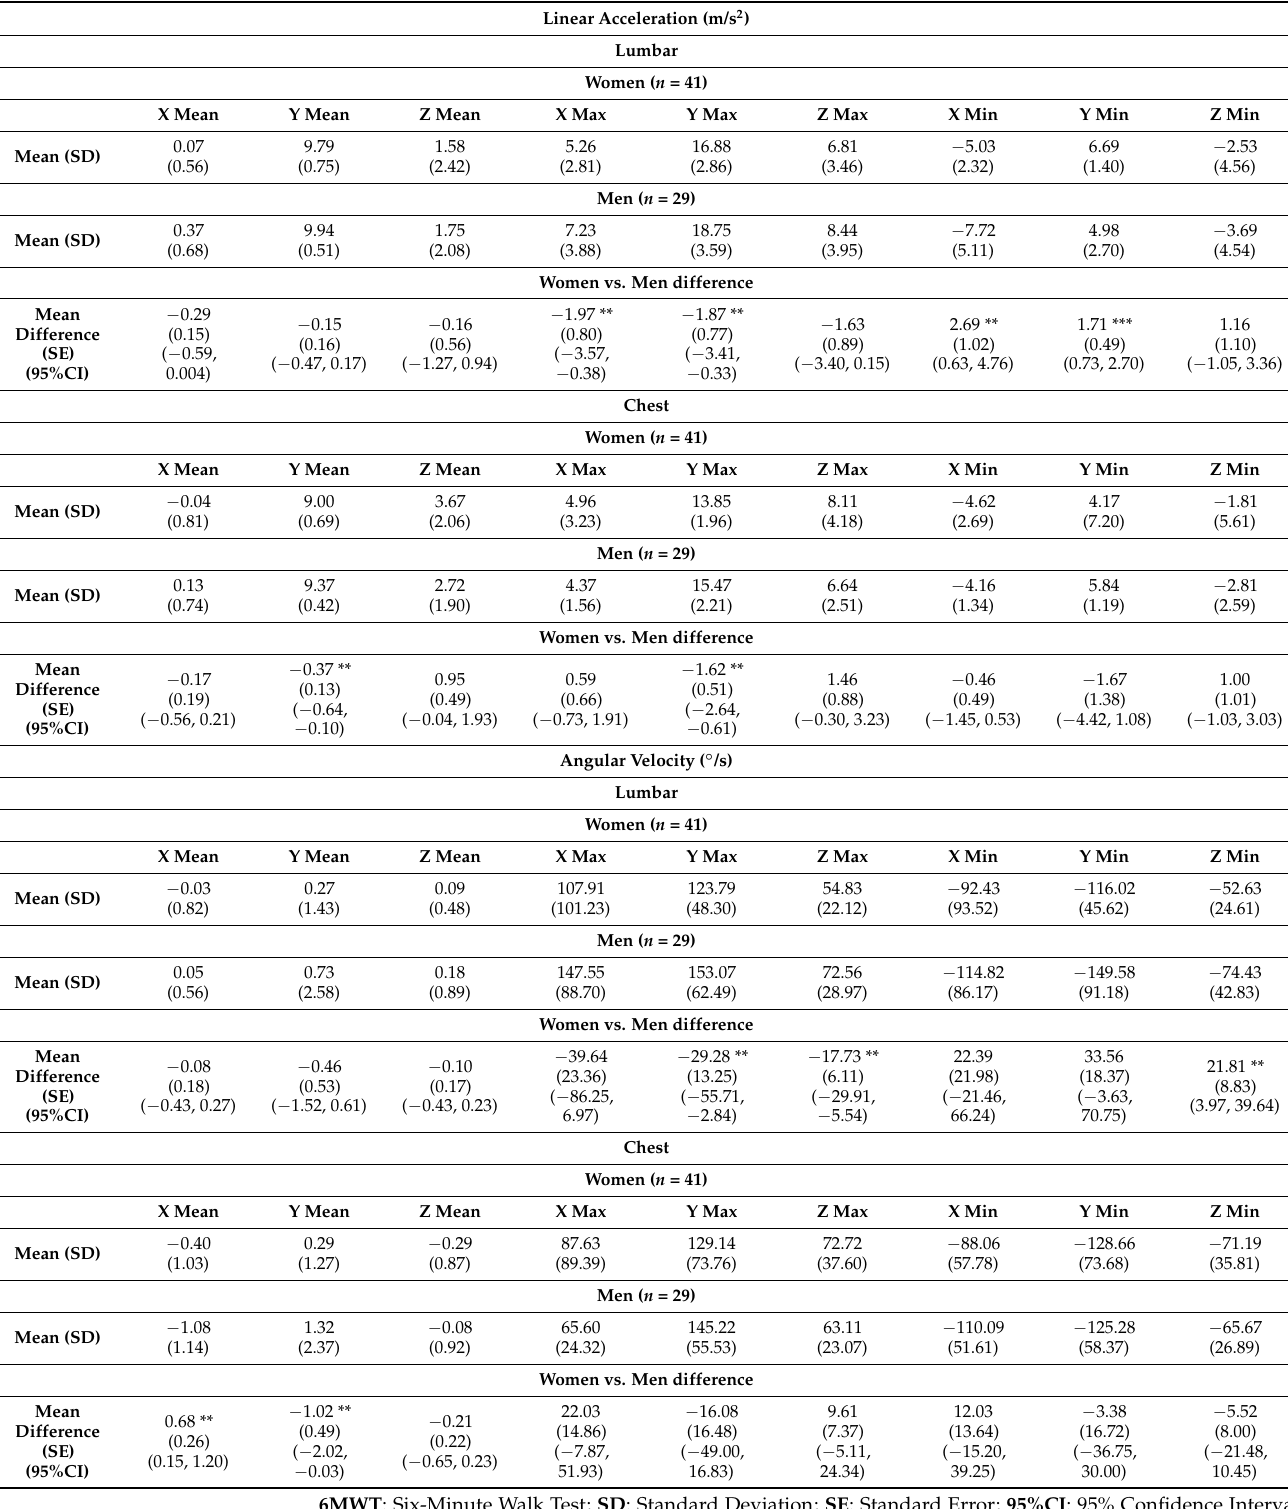
Table 6. Kinematic outcomes differences in the three dimensions between women and men in the